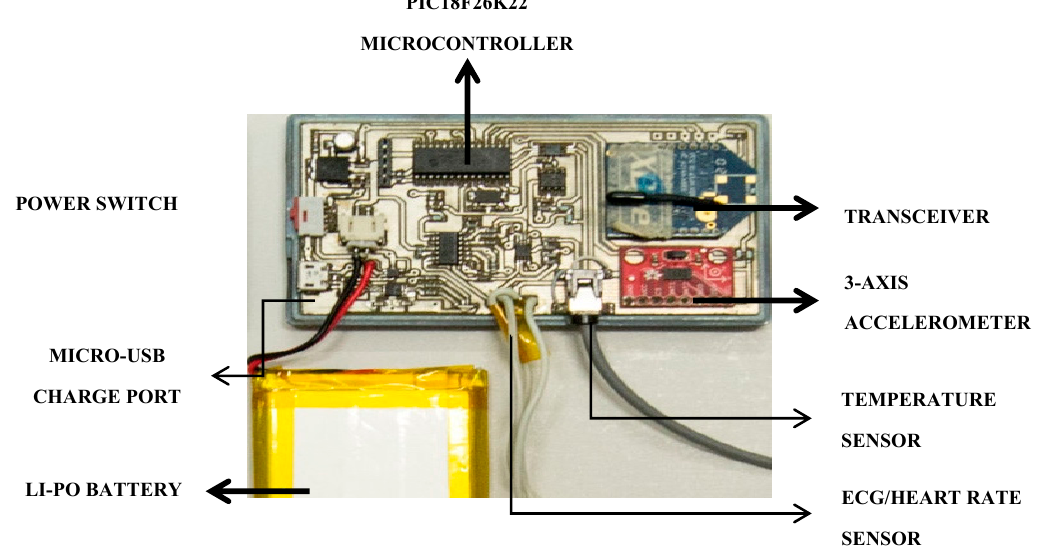
Figure 9. PlaIMoS remote node hardware.